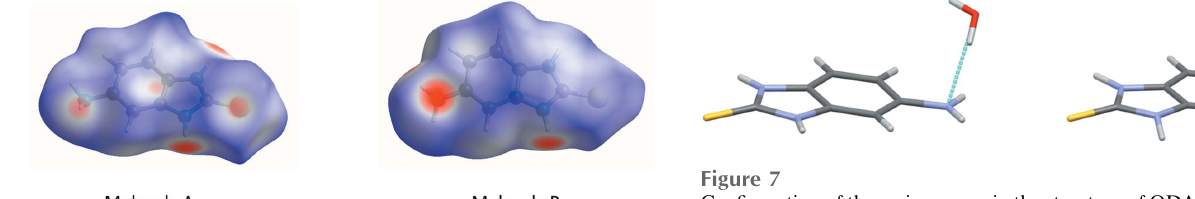
Figure 5 Hirshfeld surfaces mapped over d norm calculated for molecules A and B .